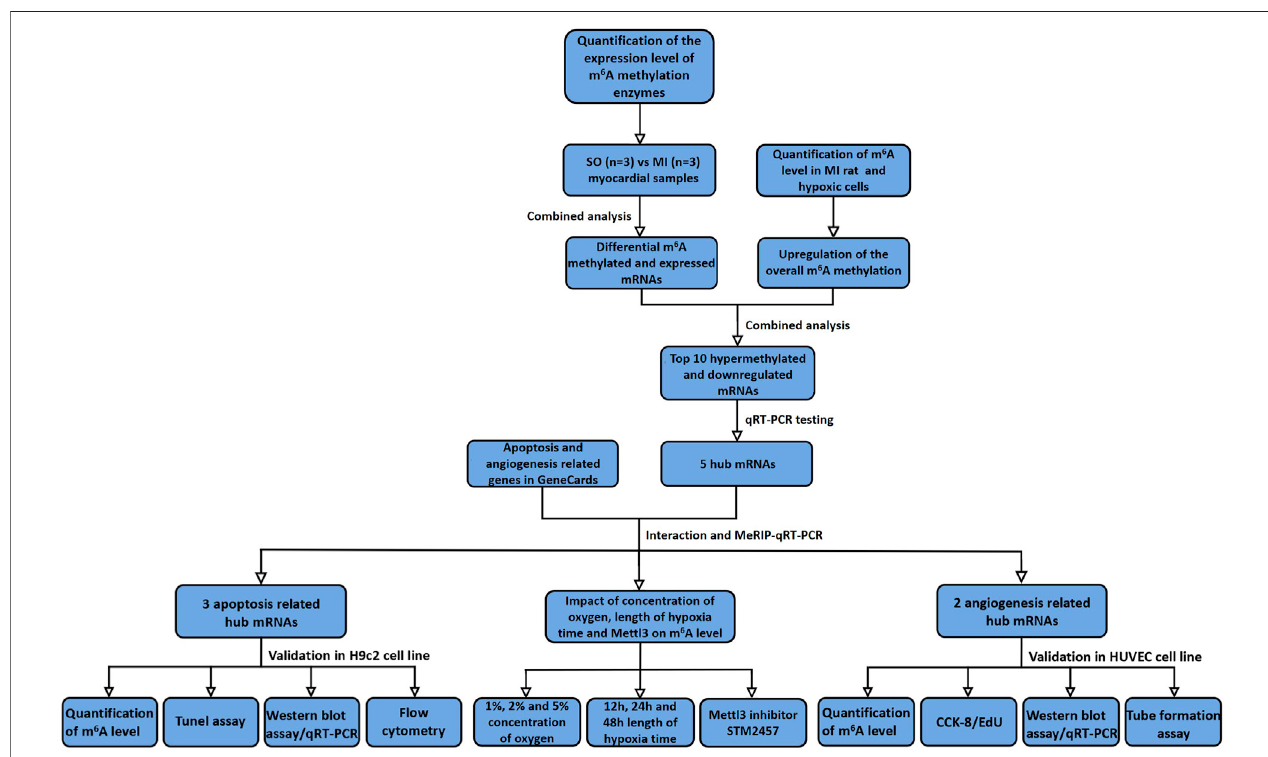
FIGURE 1 | Flowchart of study procedure. SO, sham operated; MI, myocardial infarction; qRT-PCR, quantitative reverse transcription polymerase chain reaction; MeRIP-qRT-PCR, MeRIP-quantitative real-time PCR; CCK-8, cell counting kit-8; EdU, 5-ethynyl-20-deoxyuridine.